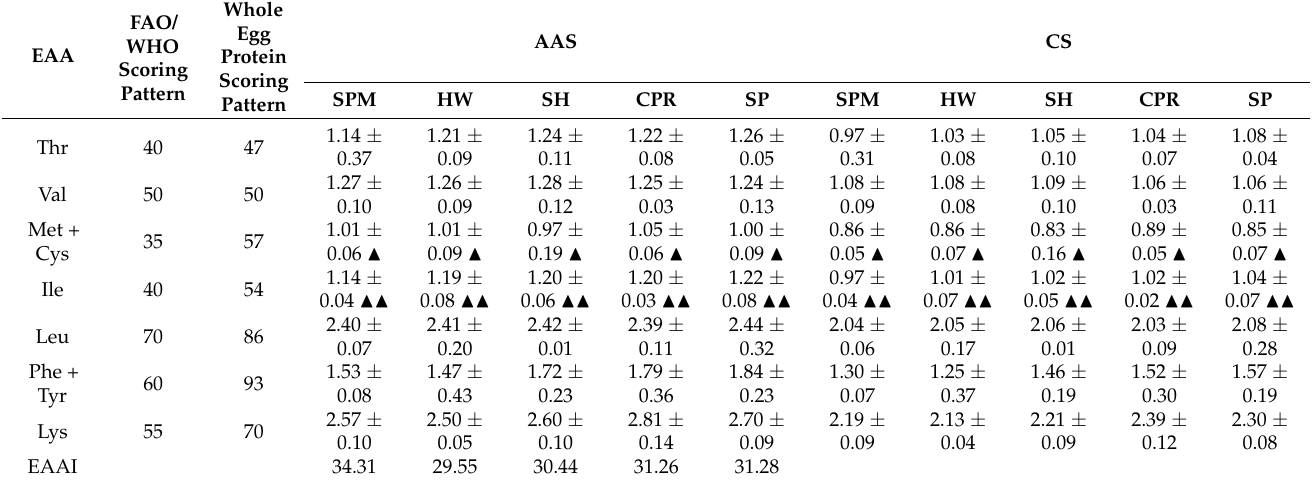
Table 7. Evaluation of essential amino acid composition in five species of common carp (mg/g).